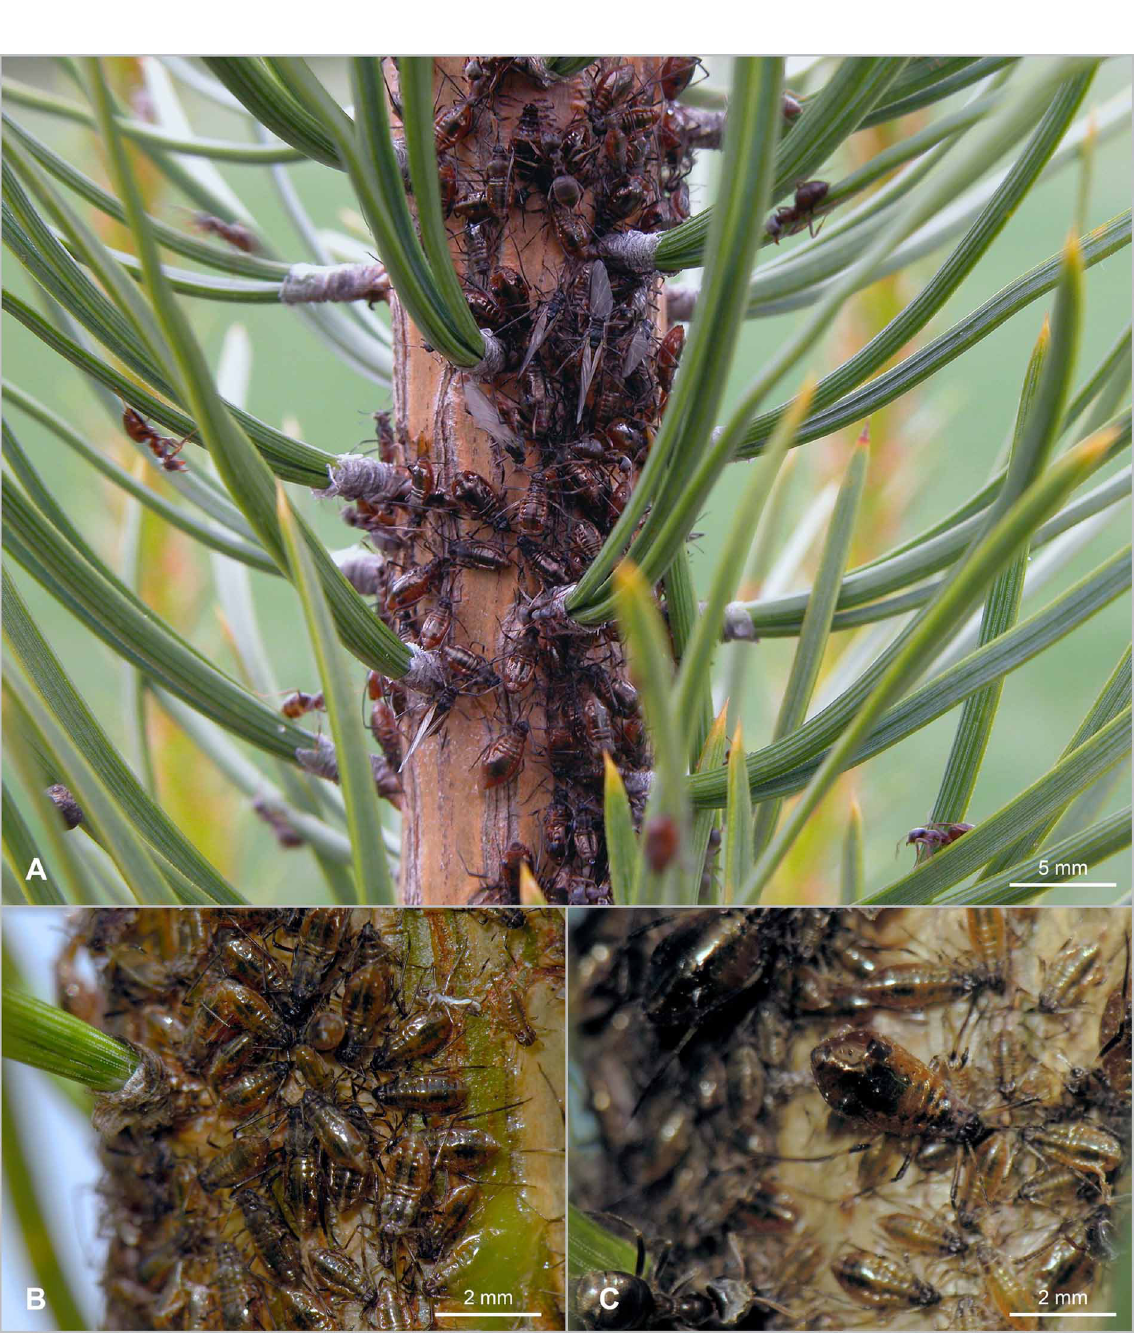
Fig. 96. Cinara (Cinara) nuda Mordvilko, 1895. Colony on trunk of young Pinus sylvestris , attended by Lasius niger (Linnaeus,